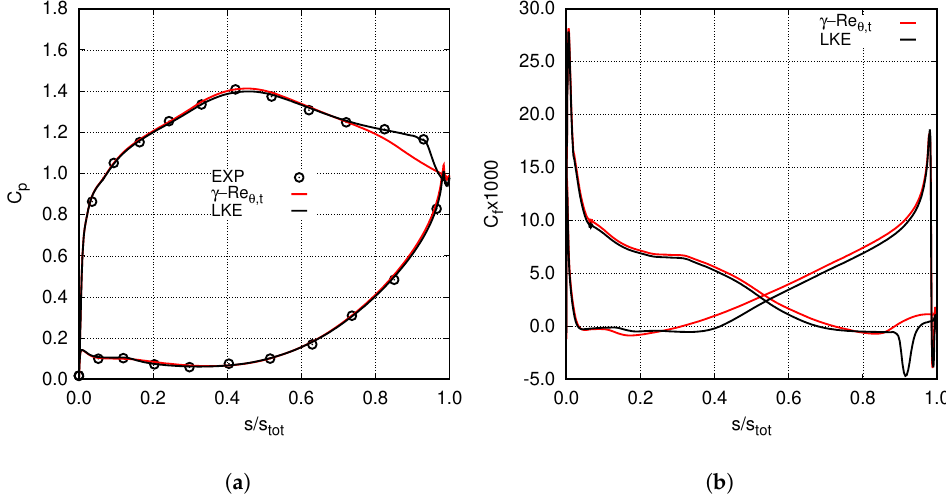
Figure 4. Blade surface distributions ( a ) pressure-coefficient ( b ) skin friction ( Re 2, is = 0.7